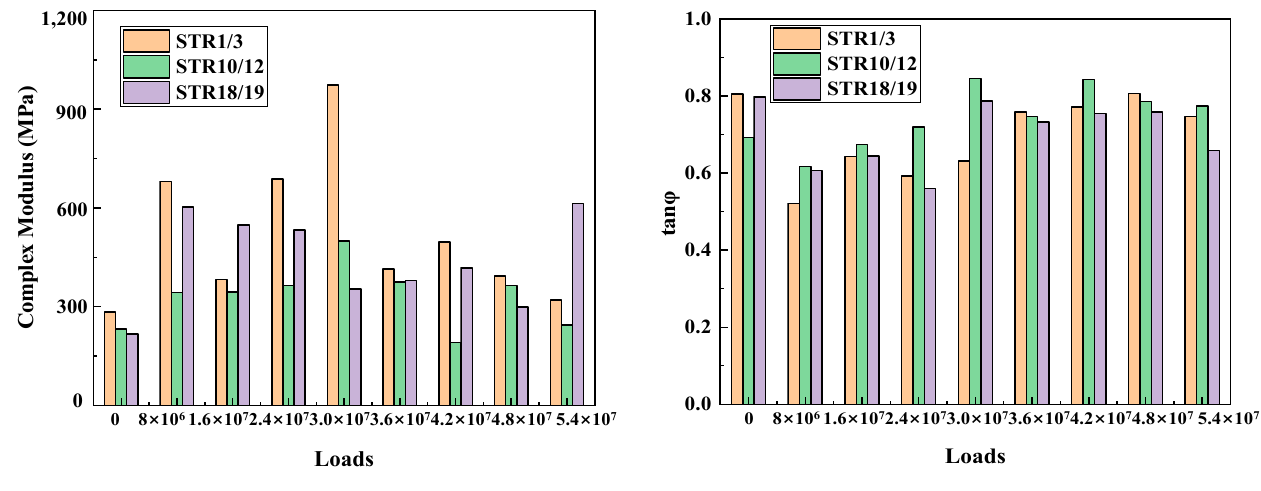
Figure 14. Complex modulus and phase angle at 60 °C for different loading cycles.